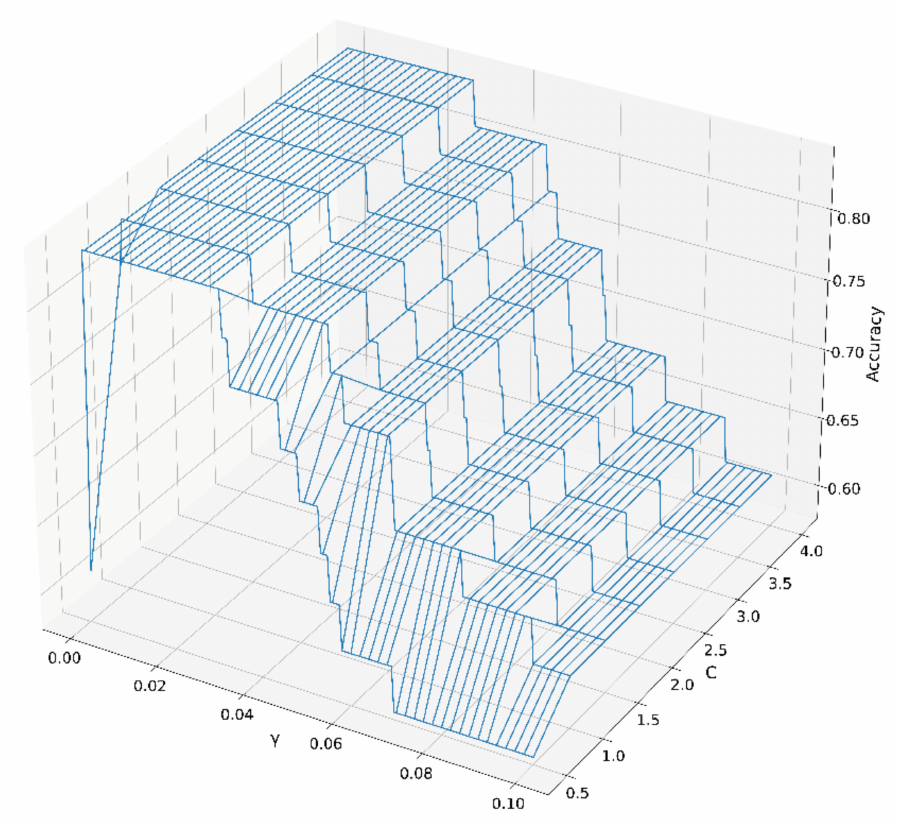
Figure 4. The accuracy of different parameters C and γ of the SVM